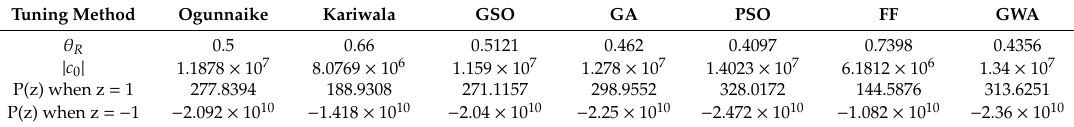
Table 14. Example 2: Jury’s stability test for pressure control ( c n = 1.5929 × 10 7 and θ Ref =